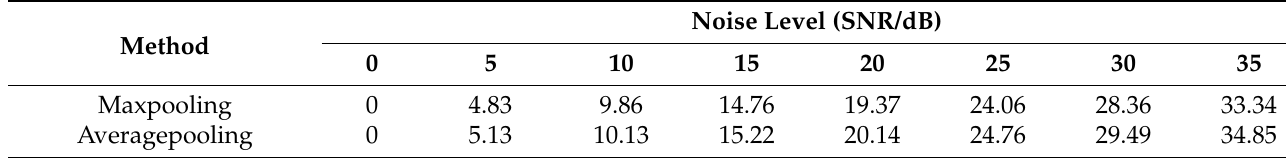
Table 2. Noise level estimates for two pooling methods.